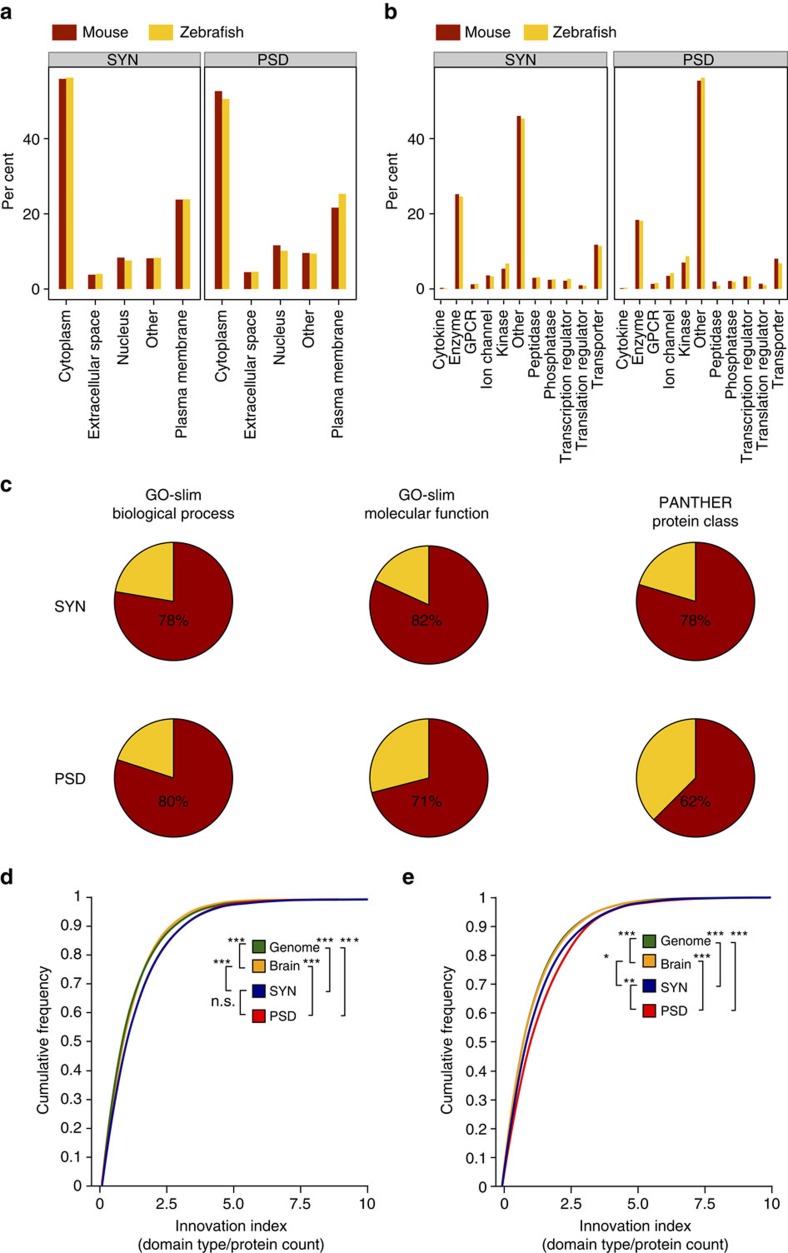
Functional similarity between mouse and zebrafish synaptic proteomes.(a) Fraction of mouse (red) and zebrafish (yellow) synaptic proteins annotated to IPA cell location categories. (b) Fraction of mouse (red) and zebrafish (yellow) synaptic proteins annotated to IPA molecular function categories. (c) Overlap between Biological Process and Molecular Function GO-slim terms68 and PANTHER Protein Classes69 enriched in mouse and zebrafish. Top row shows data for synaptosomes and bottom row for PSD proteomes. The exact percentage of overlap is indicated. (d) Cumulative frequency distribution plots of individual protein innovation index (number of unique domain types per protein) for each proteome in mouse. Statistically significant comparisons between pairs of distributions (two-tailed Kolmogorov–Smirnov test applied to distributions) are shown at the legend. ***P<0.001, **P<0.01, *P<0.05; nonsignificant comparisons are not shown. (e) Cumulative frequency distribution plots of individual protein innovation index (number of unique domain types per protein) for each proteome in zebrafish. Statistically significant comparisons between pairs of distributions (two-tailed Kolmogorov–Smirnov test applied to distributions) are shown at the legend. ***P<0.001, **P<0.01, *P<0.05; nonsignificant comparisons are not shown.